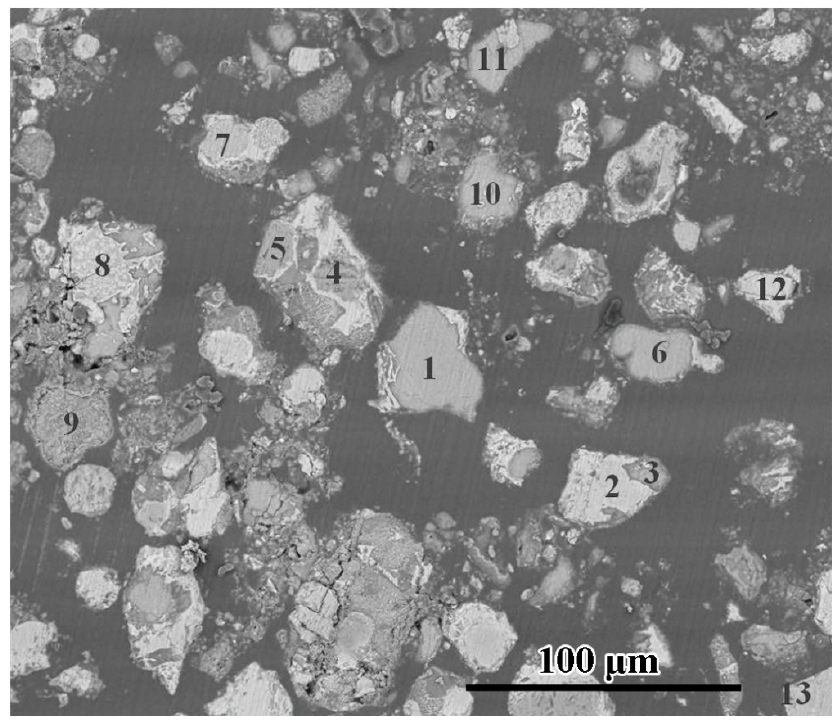
Figure 3. The SEM images of as-received EAF slag.